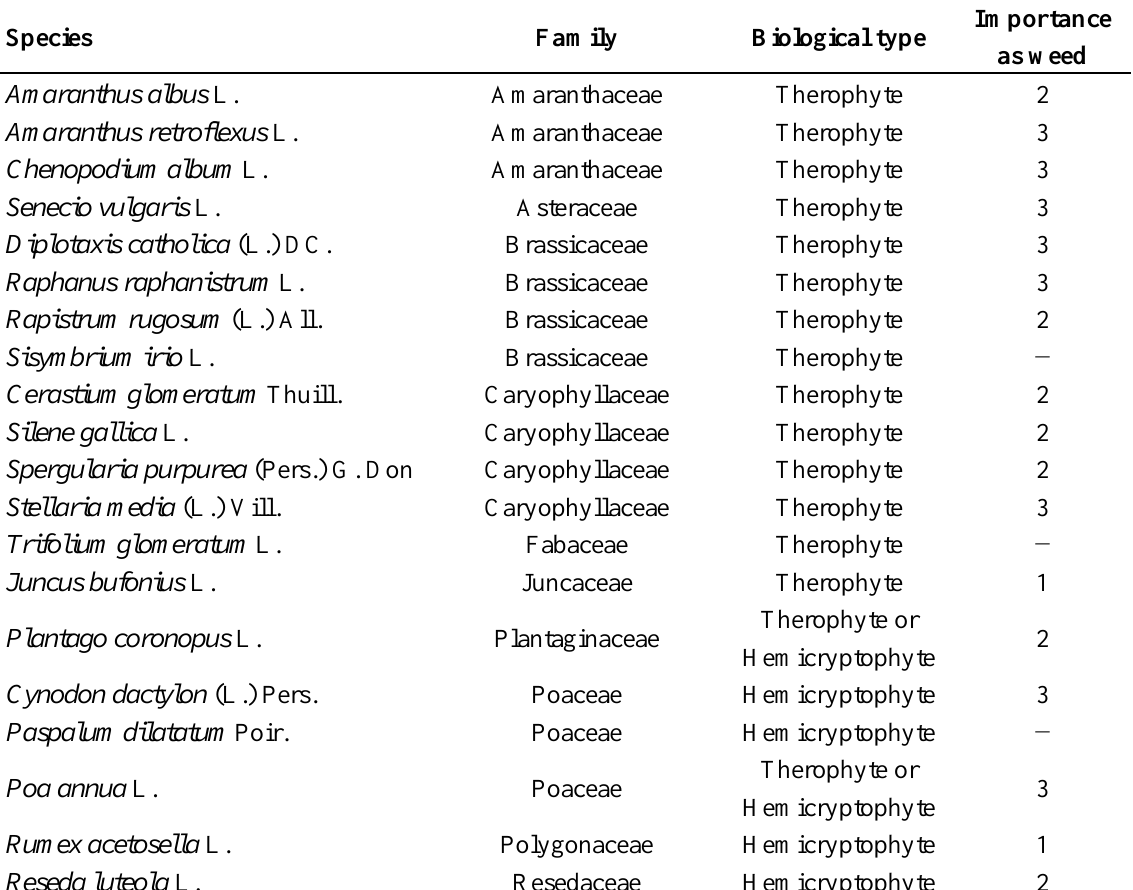
Table 1. Species, families, biological type, and importance as weed according to [40], of seeds in the soil seed